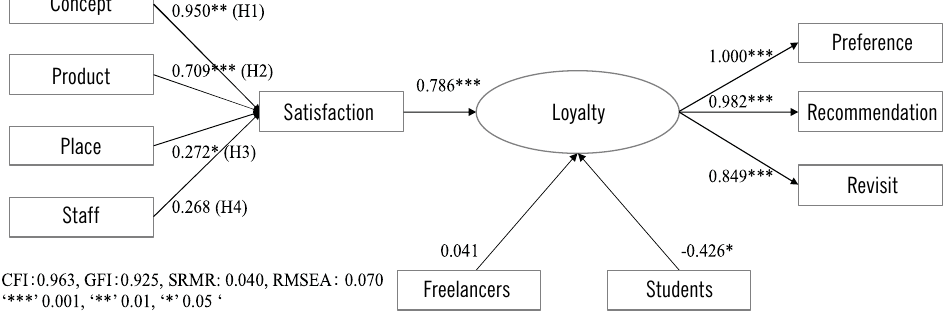
Source: own elaboration.